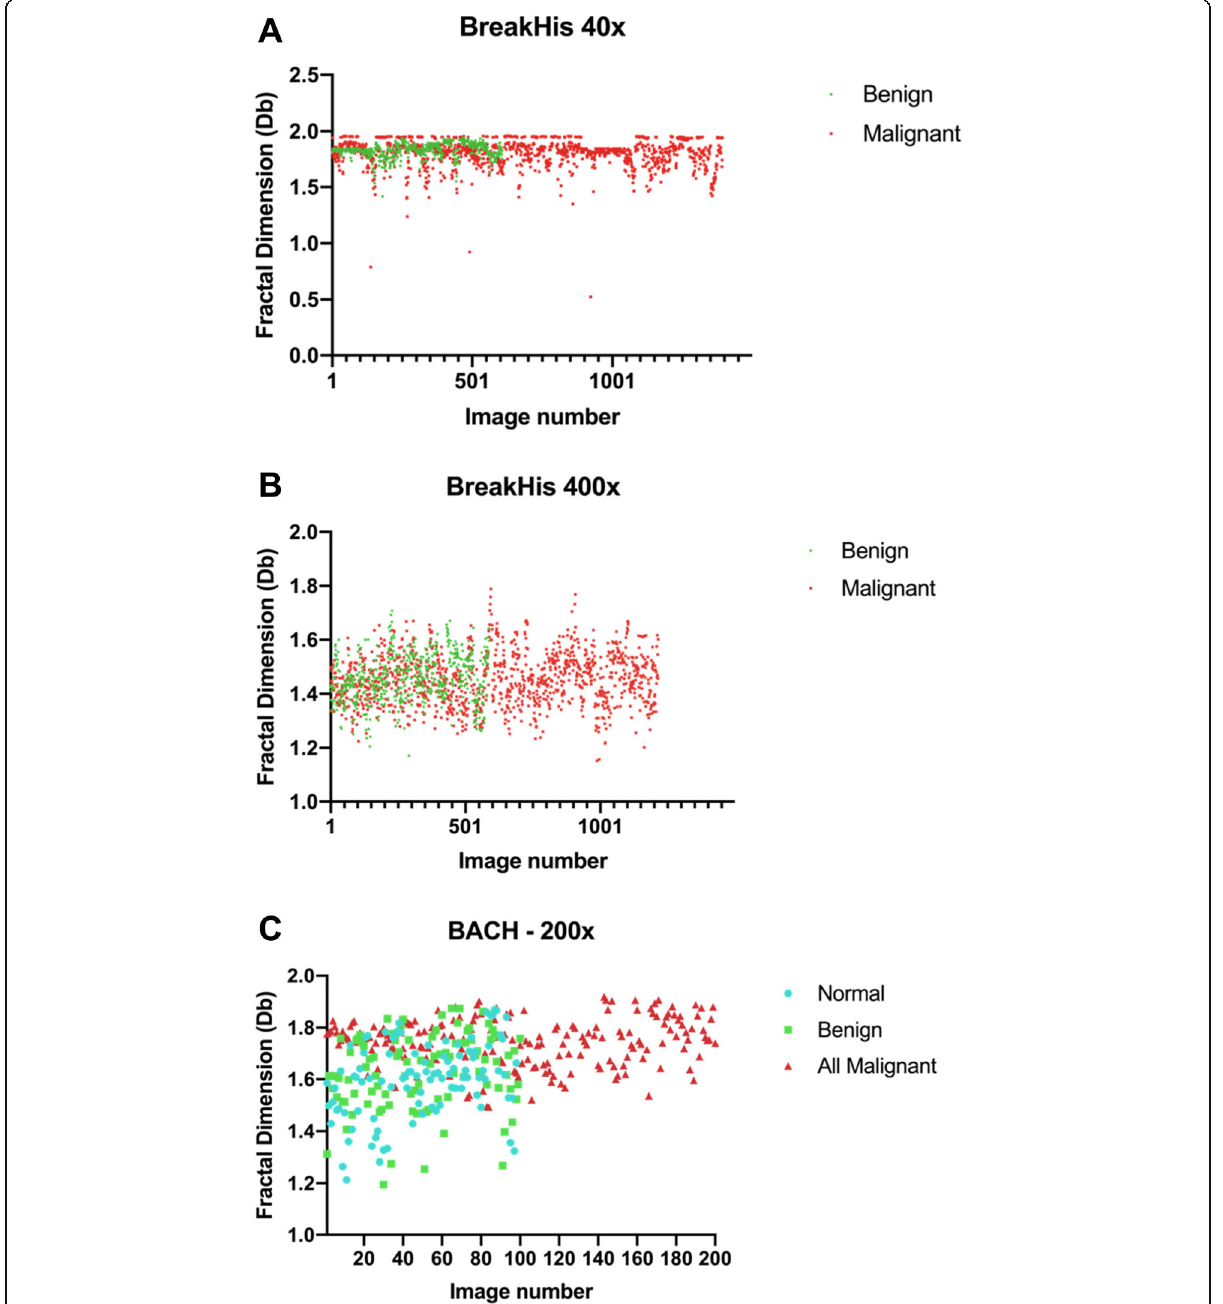
Fig. 4 a Db distribution between benign and malignant images from BreakHis under 40x magnification; b Db distribution between benign and malignant images from BreakHis under 400x magnification; c Db distribution between normal tissue, benign and malignant images from set